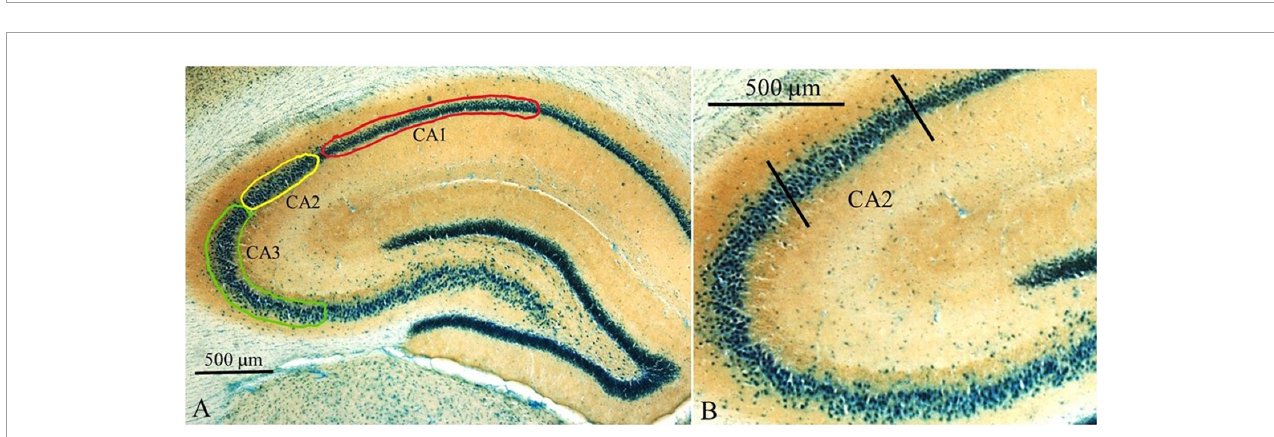
FIGURE7 Overview of counting areas for hippocampal regions. (A) Lower magnification image (2.5x) of dorsal hippocampus showing the CA1, CA2, and CA3 regions. Areas where c-Fos counts were carried out are shown as outlined: green–CA3; yellow–CA2; red–CA1. (B) Higher power magnification (10x) delineating the CA2 region from the CA3 and CA1. Sections were stained with thionin to highlight cell bodies and to aid in the delineation of the boundary between the CA2 and CA1 subfields. Brown staining represents synaptophysin to aid with determining the boundary between the CA3 and CA2